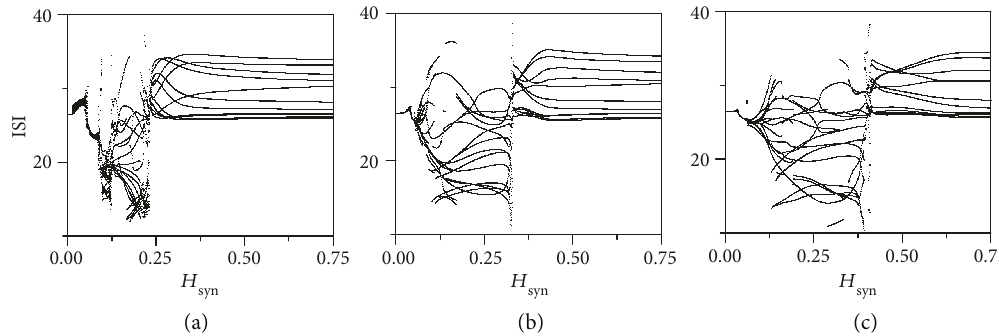
ff erent coupling strengths. The time lag τ = 100 , (a) C = 0 1 ; syn for di